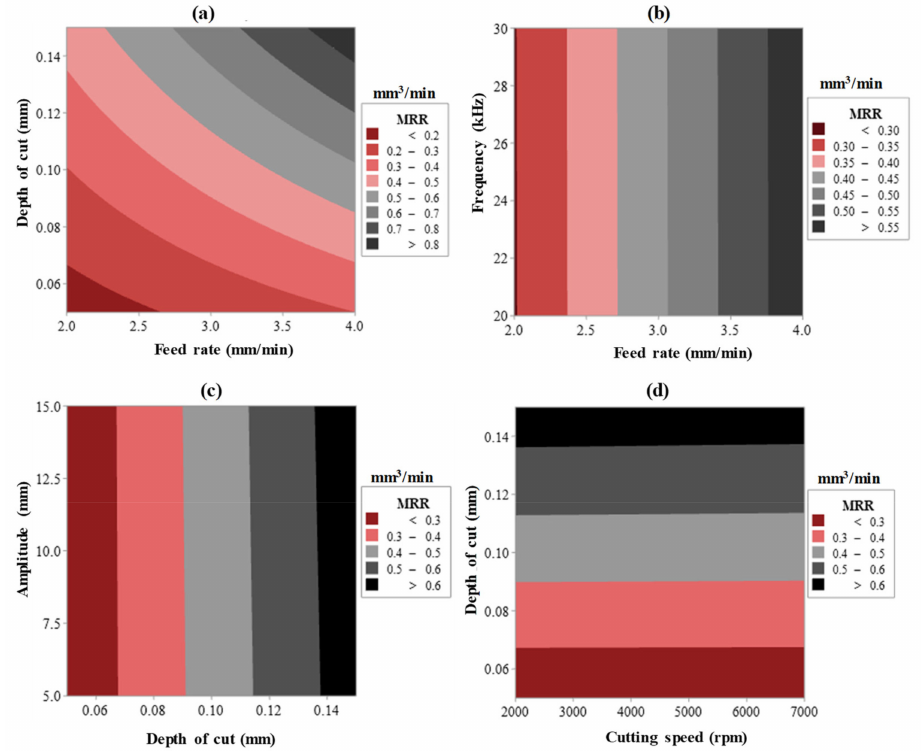
Figure 13. Two variable interactive e ff ects of ( a ) feed rate × depth of cut, ( b ) feed rate × frequency, ( c ) depth of cut × amplitude, and ( d ) cutting speed × depth of cut on